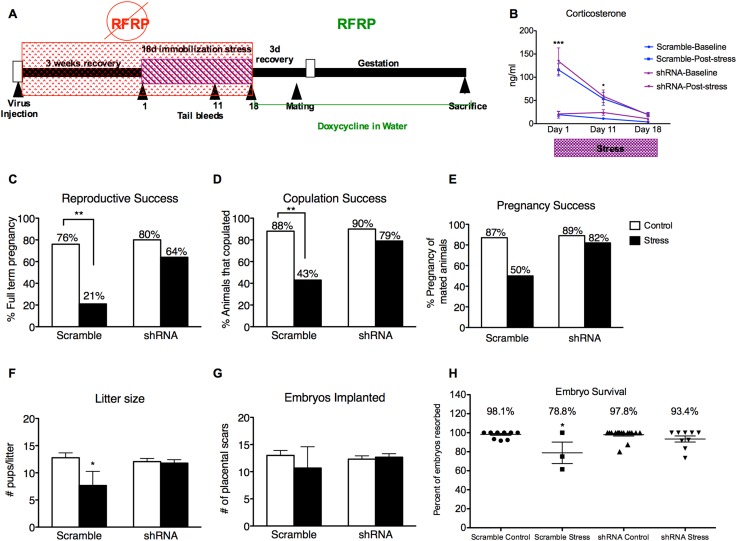
Knocking down RFRP during stress completely prevents stress-induced reproductive dysfunction.(A) Experimental time line. (B) Corticosterone concentrations were measured in serum samples from tail vein blood immediately before and after stress sessions on days 1, 11, and 18. (C) Total reproductive success was measured as percentage of females that successfully brought a litter to full term (Scramble/control N = 17, Scramble/Stress N = 14, shRNA/control N = 20, shRNA/stress N = 14, g-statistics: G = 5.836, df = 1 p = 0.016, fisher's exact test p = 0.0031). Breaking down total reproductive success, (D) copulation success was measured as percentage of females that exhibited lordosis and allowed a male to achieve intromission within 15 min (g-statistics: G = 2.405, df = 1 p = 0.028, fisher's exact test p = 0.0062), and (E) pregnancy success refers to the percentage of females that got pregnant out of the subgroup that successfully copulated (Scramble/control N = 15, Scramble/Stress N = 6, RFRP-shRNA/control N = 18, RFRP-shRNA/stress N = 11). (F) Litter sizes measured as number of pups born alive immediately after birth (dams-Scramble/control N = 13, Scramble/Stress N = 3, RFRP-shRNA/control N = 16, RFRP-shRNA/stress N = 9). (G) Embryos implanted measured as number of placental scars identified in the dam's uterine horns after birth. (H) Embryo survival was calculated as the number of birthed pups divided by number of maternal placental scars and shown as a percentage (indicative of initial implantation, mean ± SEM) *p < 0.05, **p < 0.01, ***p < 0.001. Reproductive success statistics were done by G-statistics tests followed by Fisher's Exact test, statistics for litter size, placental scars, and embryo resorption were done by a two-way analysis of variance (ANOVA) followed by Bonferroni post-hoc tests and CORT statistics analyzed by a repeated two-way ANOVA.